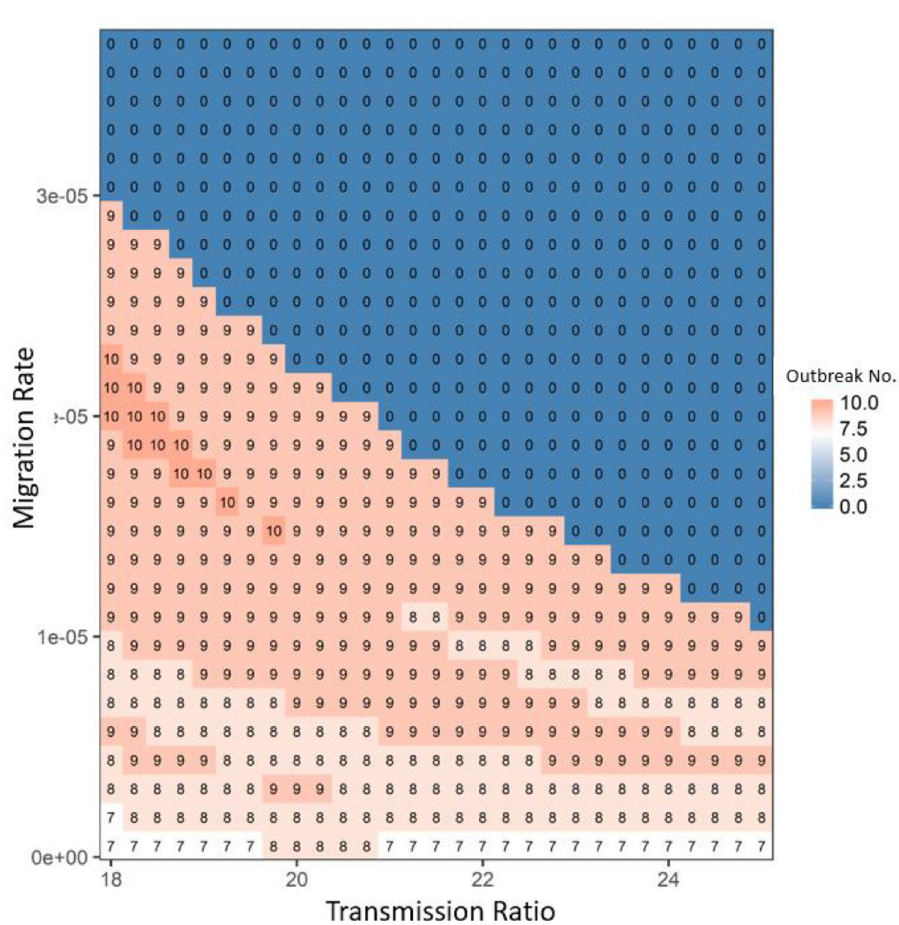
Figure 5. The average disease outbreak numbers in the last 25 generations (total simulated generations are 50) under the influences of transmission ratio and migration rate for patch #30, where robust type provides the baseline transmission rate. The color trend with numbers represent the trend of outbreak numbers: from blue to white to red, outbreak numbers increase. All the other parameters are: r R = 0.15, r W = 0.2, r Wd = r Rd = 0.01, r Wr = r Rr = 0.2, α W = α R = 0.05, μ W = μ R = 0.0005, γ W = γ R = 0.05 and β RR = β WR = 0.000005. In focal patch #1, the initial susceptibles of both types are 200, infecteds are 5, and recovereds are 0. Other patches show similar